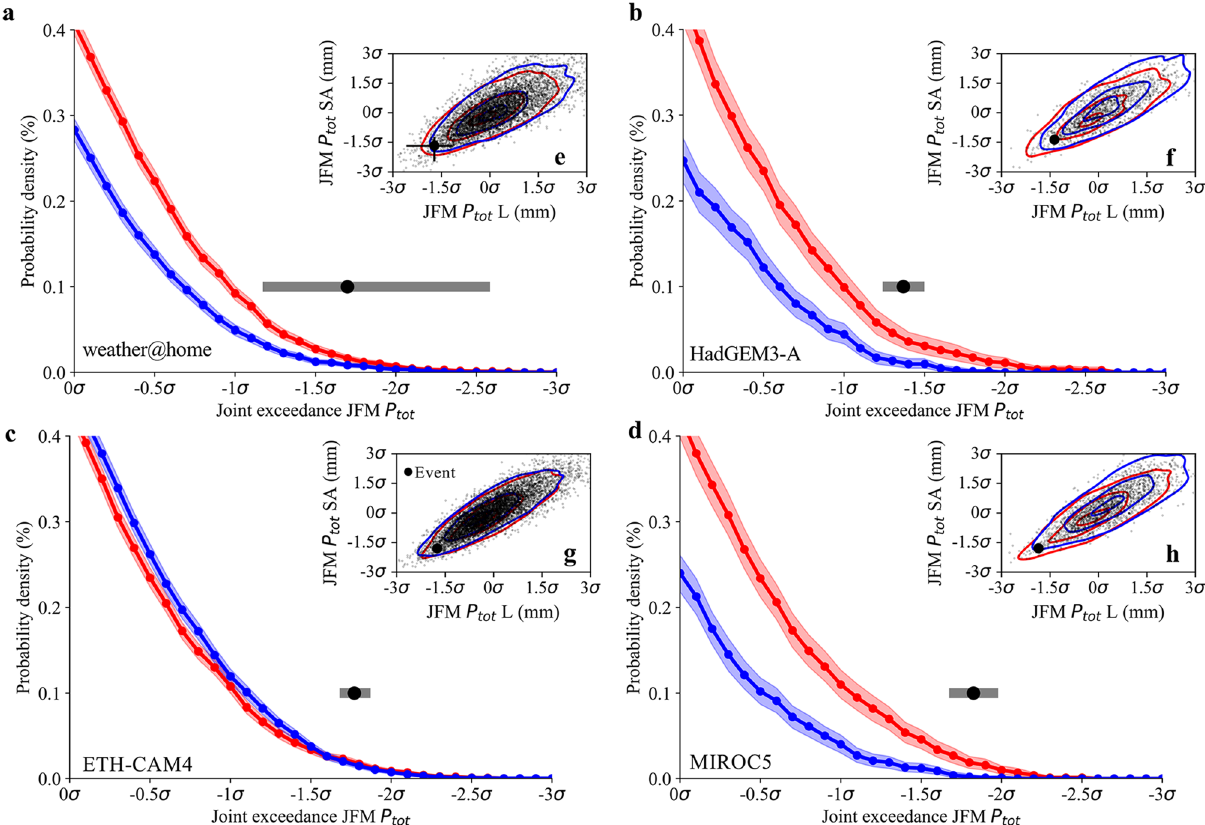
Figure 2. Joint probability plot of the 2007 drought. ( a ) The lower tail (dry–dry) joint probability plot in the weather@home model with red showing the ACT world and blue showing the NAT world without CC. The horizontal grey bars indicate the 10–90% uncertainty estimates of the event using bootstrapping, with the black marker showing the mean estimate. The tails of the distribution are derived empirically. ( b – d ) Same as ( a ) but for HadGEM3-A ( b ), ETH-CAM4 ( c ) and MIROC5 ( d ). ( e ) Joint probability plot, with contour lines derived from kernel density estimates, in the weather@home model. The black marker indicates the 2007 event. ( f – h ) Same as ( e ) but for HadGEM3-A ( f ), ETH-CAM4 ( g ) and MIROC5 ( h ). The uncertainty around the 2007 event is only visible for weather@home given the larger uncertainty in this model, whereas for the other models the uncertainty is not clearly visible relative to the size of the